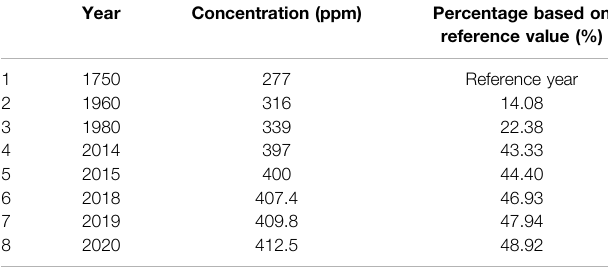
TABLE 2 | Increase in CO 2 concentration between 1750 and